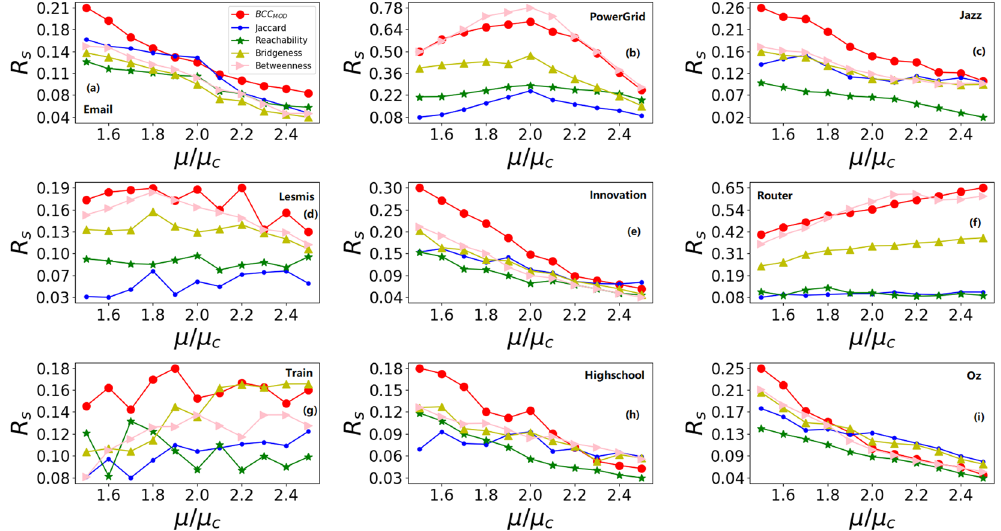
Figure 3. The relative differences of real infected scale R s after removing top 5% ranking edges under different infect rates. All results are averaged over 100 independent implementations.